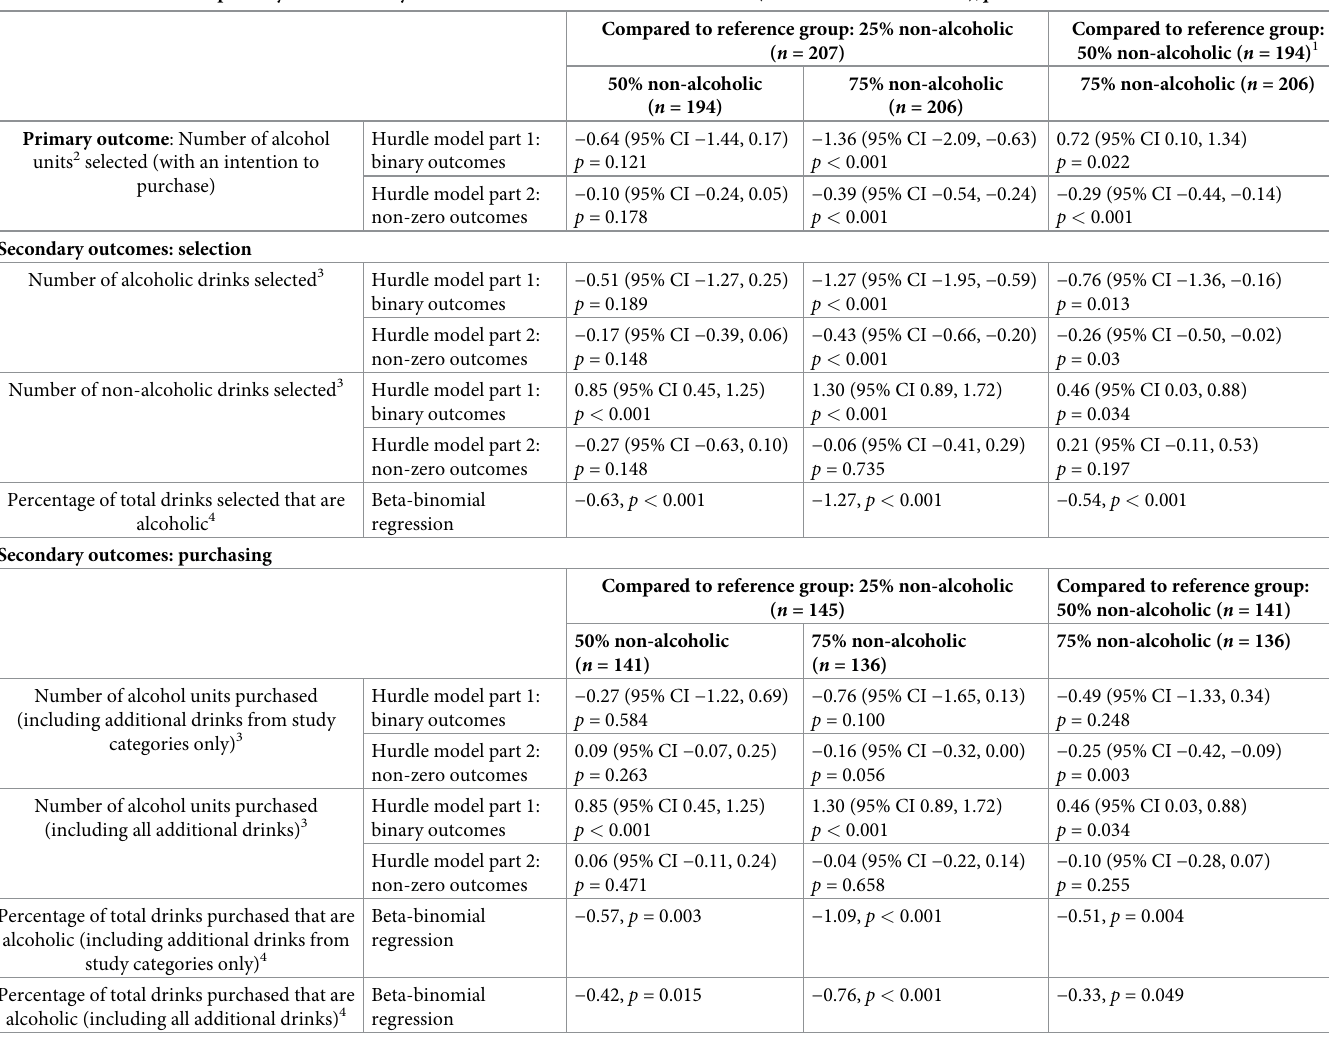
Table 3. Model results for primary and secondary outcomes: Estimates from hurdle models (95% confidence intervals), p